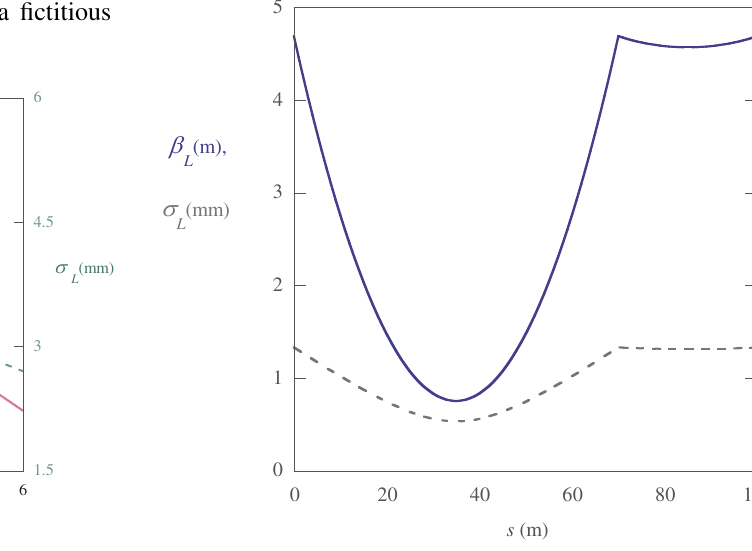
FIG. 16. (Color) Beta function (full blue line) and bunch length (dashed gray line) along the ring for monotonic R (cid:6) U ) at a drift distance R equal cavities ( U 1 2